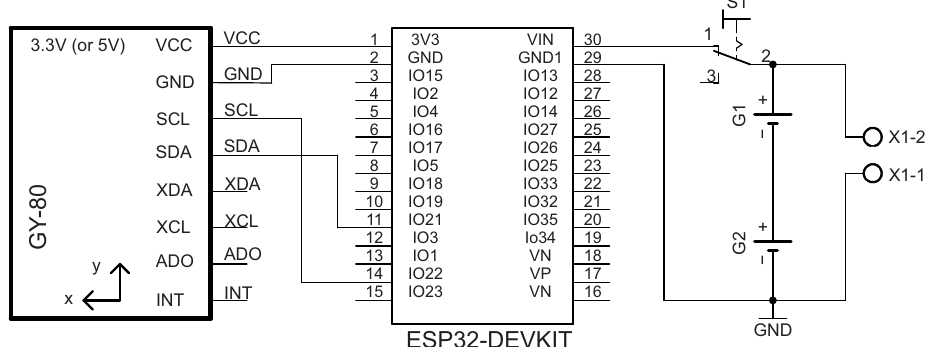
Figure 1. JAMA circuit can be configured to ESP32 to connect to GY-80 via I 2 C master mode. The microcontroller uses pins 1 and 2 for power supply (the I 2 C typically supports 3.3 V or 5 V), and pins 21 and 22 connect to the bidirectional transmission lines Serial Data (SDA) and Serial Clock (SCL),